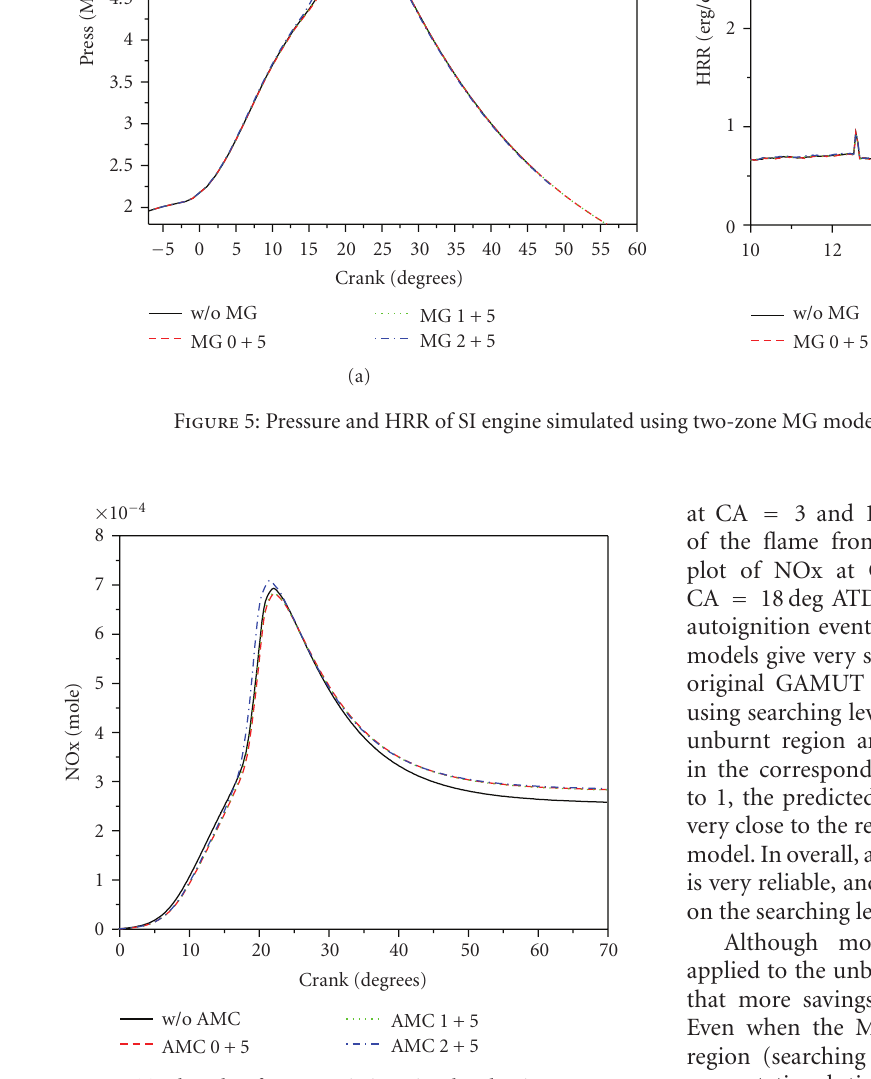
Figure 6: Total mole of NOx emission simulated using two-zone MG model with di ff erent searching levels.